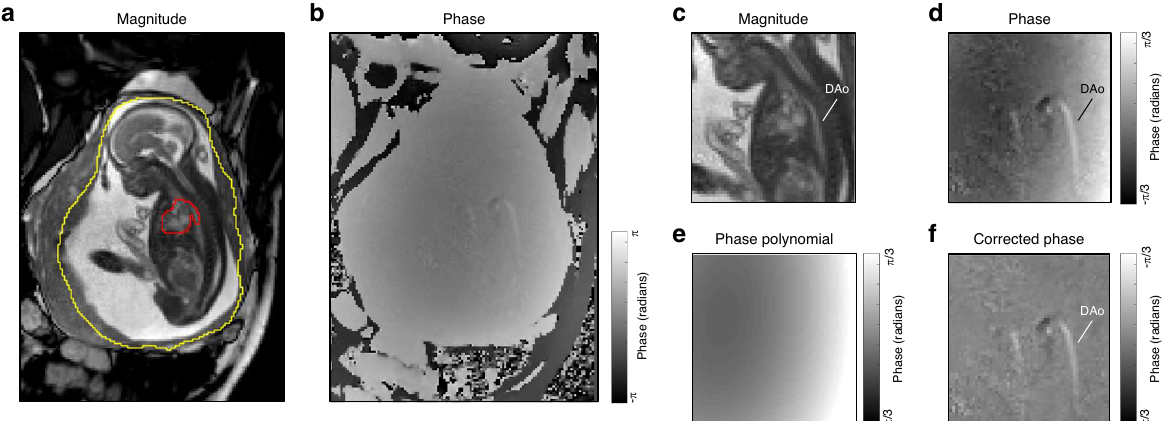
Fig. 9 Background phase correction of bSSFP images. Images shown were acquired in a healthy 24 + 2 week fetus (ID03). a Magnitude image showing the in-plane regions of two volumes of interest drawn around the mother ’ s uterus (yellow) and the fetal heart, including great vessels (red). b Corresponding uncorrected phase image. c Zoomed-in magnitude image showing the descending aorta (DAo). d Zoomed-in uncorrected phase image demonstrating the background phase variation, windowed to accentuate phase roll. e Third-order polynomial fi t calculated from the uncorrected phase image using the uterus volume of interest but excluding the fetal heart and great vessels. f Corrected phase image after subtraction of the background phase estimate leaving localized phase changes that are then used to calculate the velocity vector fi